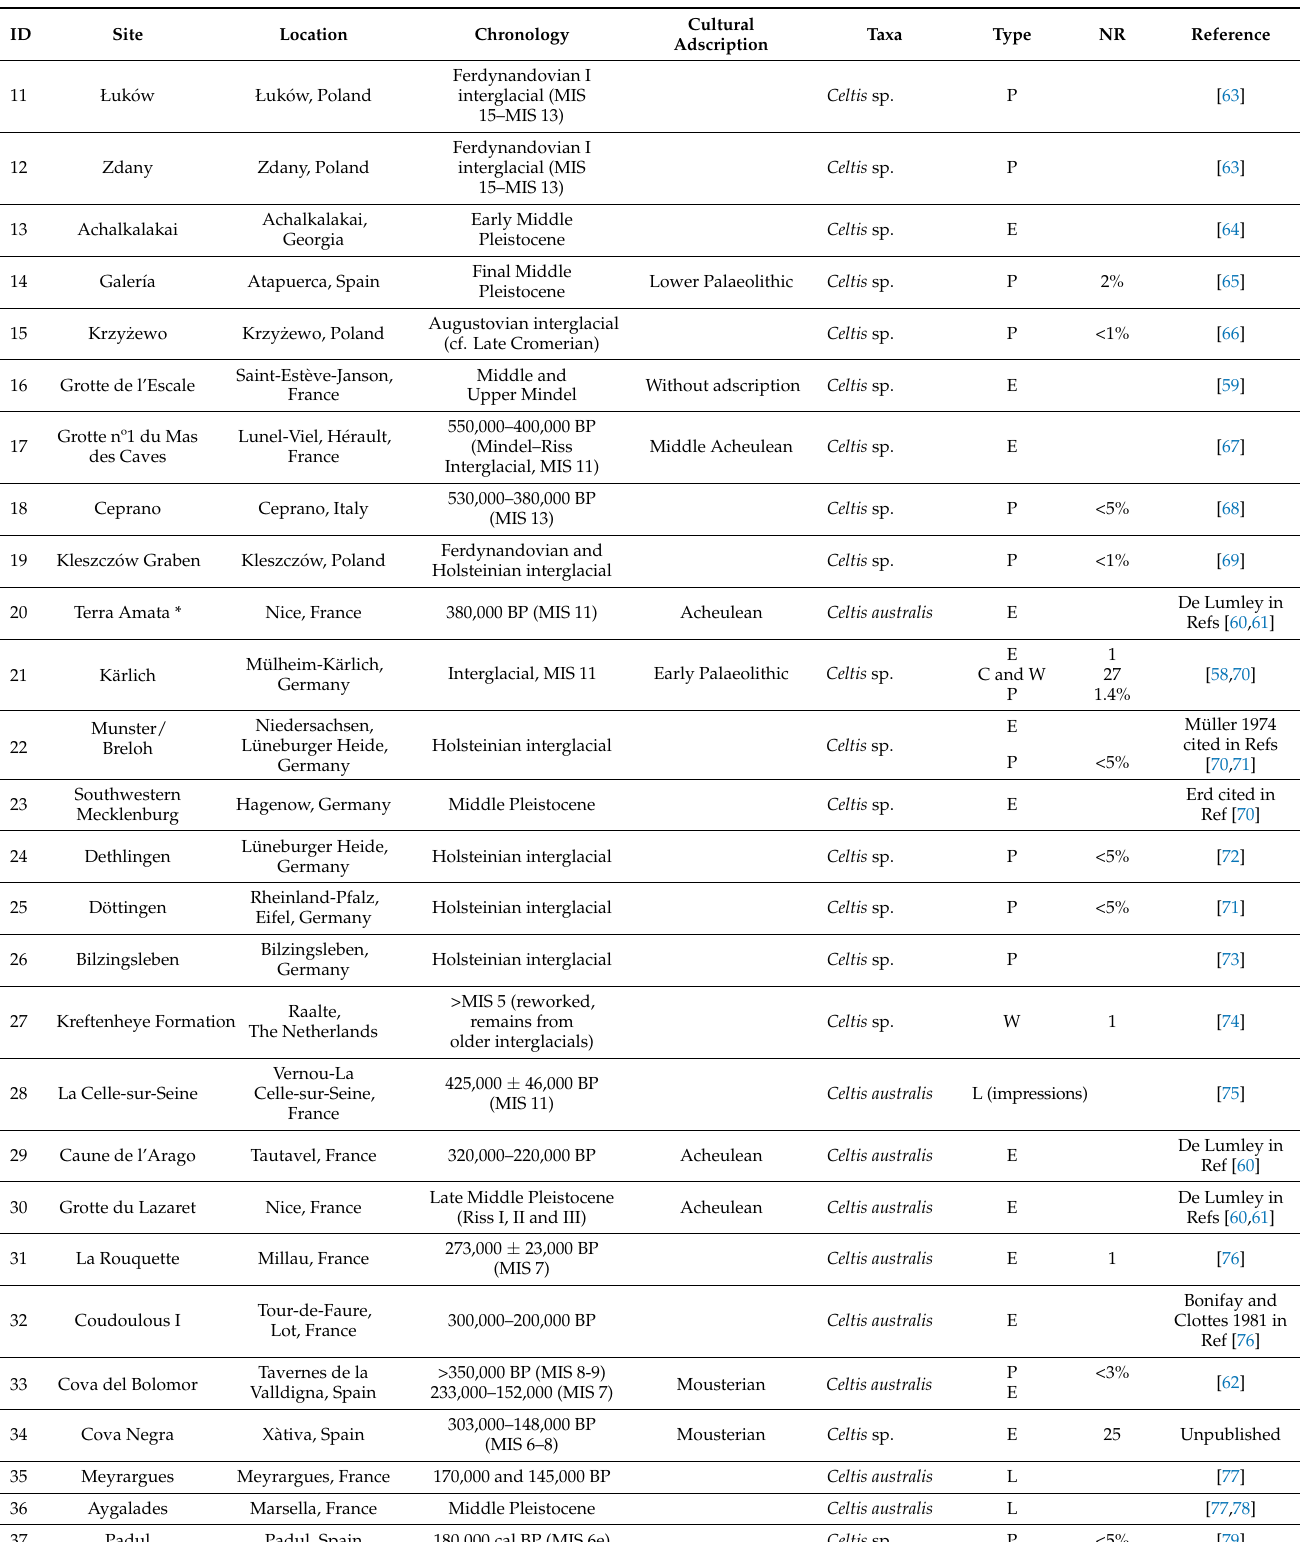
Table 2. Middle Pleistocene sites where Celtis remains were reported (types of remains: wood